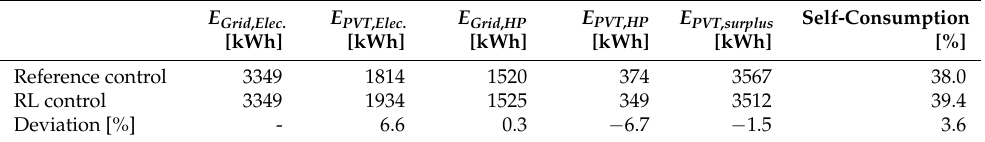
Table 4. Evaluation results of the agent with highest training success compared to the reference